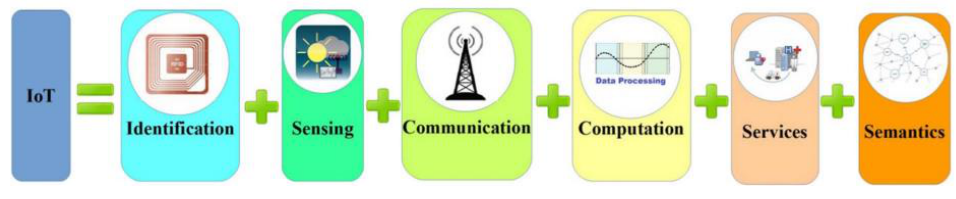
Figure 16. IoT elements [118].